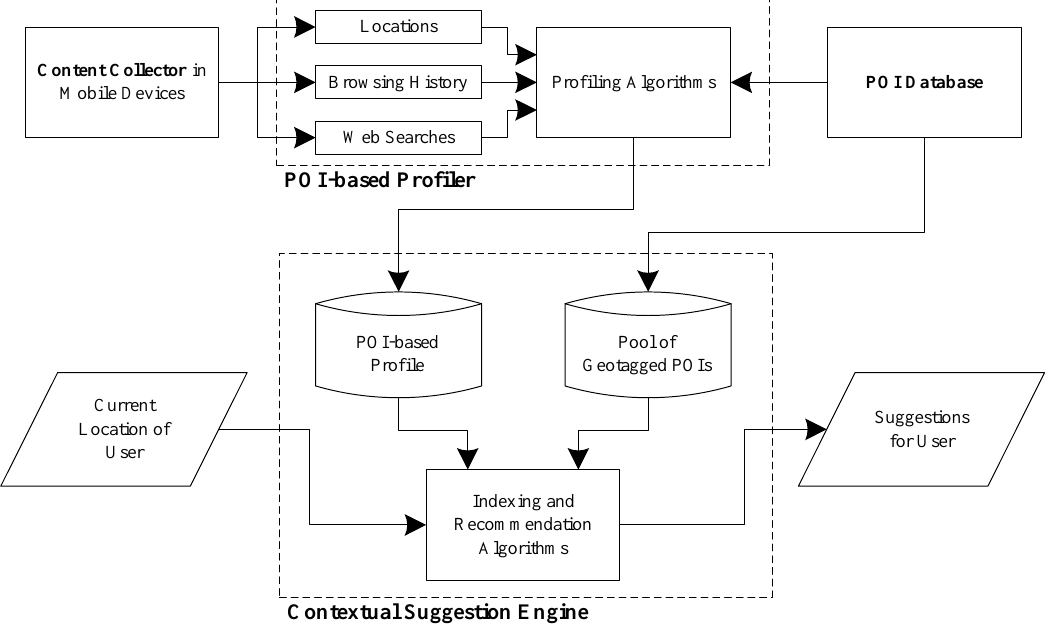
Figure 2. Interaction of the Pythia